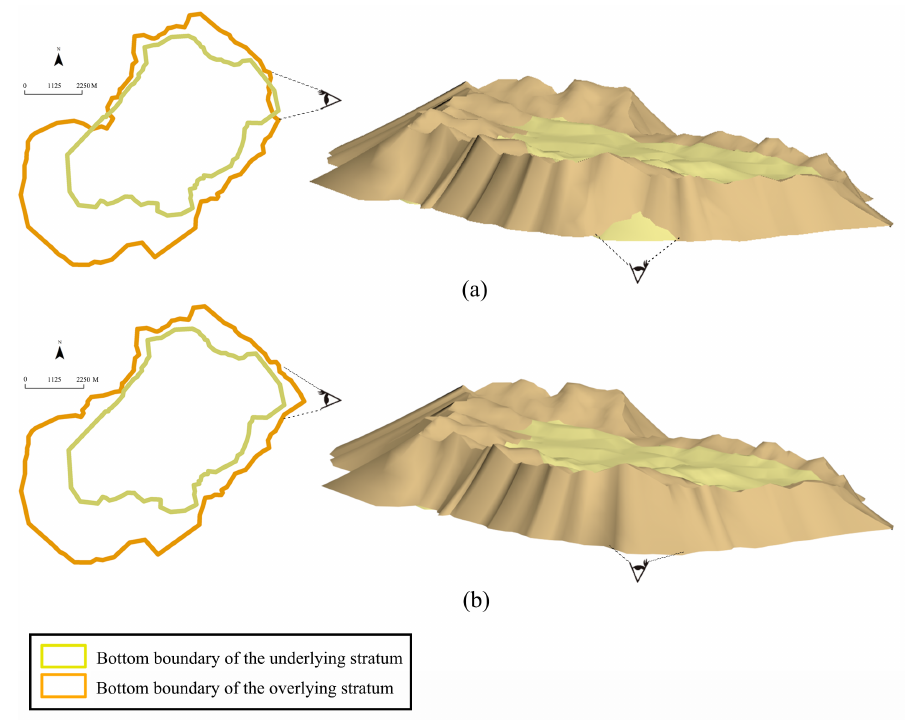
Figure 20. Interface penetration treatment: ( a ) The strata penetrated; ( b ) the strata